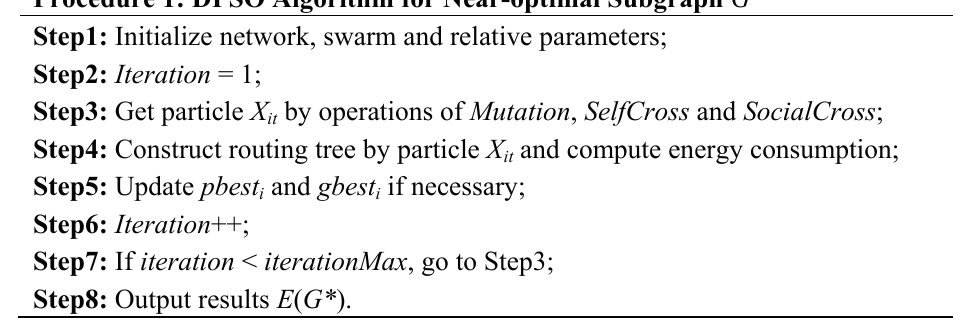
Procedure 1: DPSO Algorithm for Near-optimal Subgraph